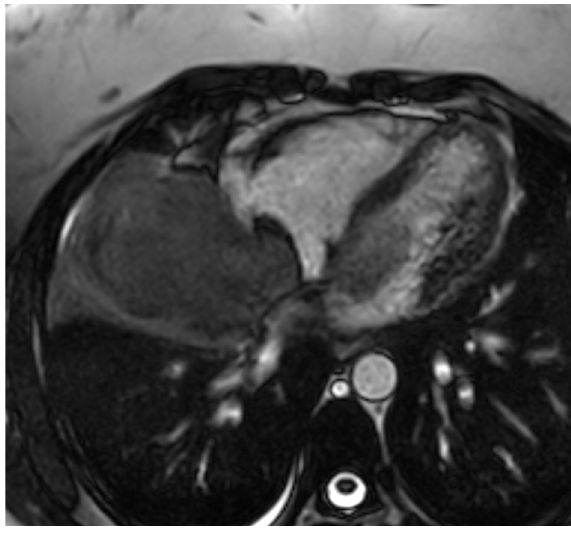
Figure 4. Cardiac MRI (axial cine-MRI sequence): prolapse of the mass of LA via the mitral